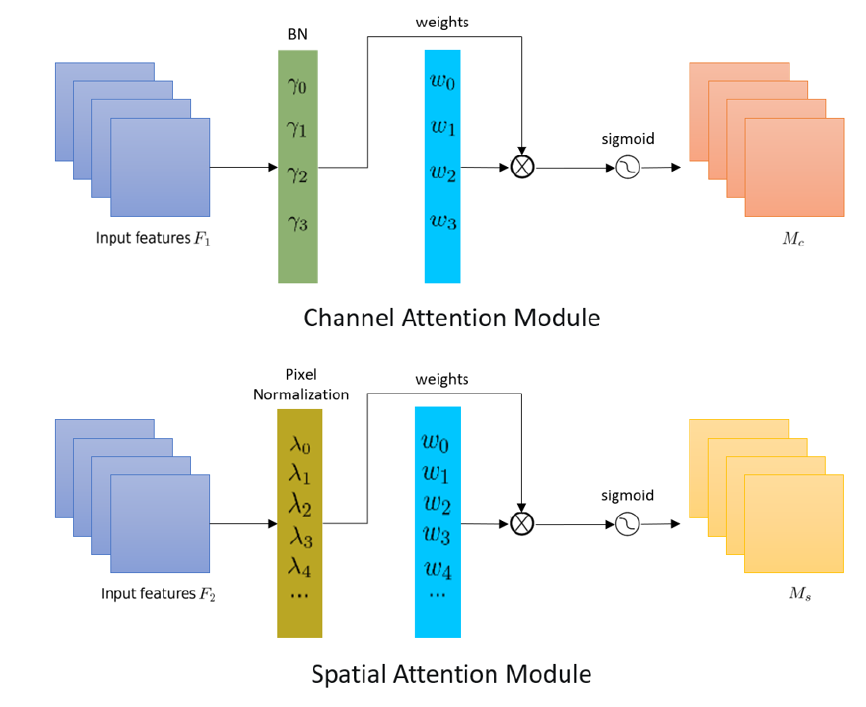
Figure 6. The channel attention submodule and the spatial attention submodule in